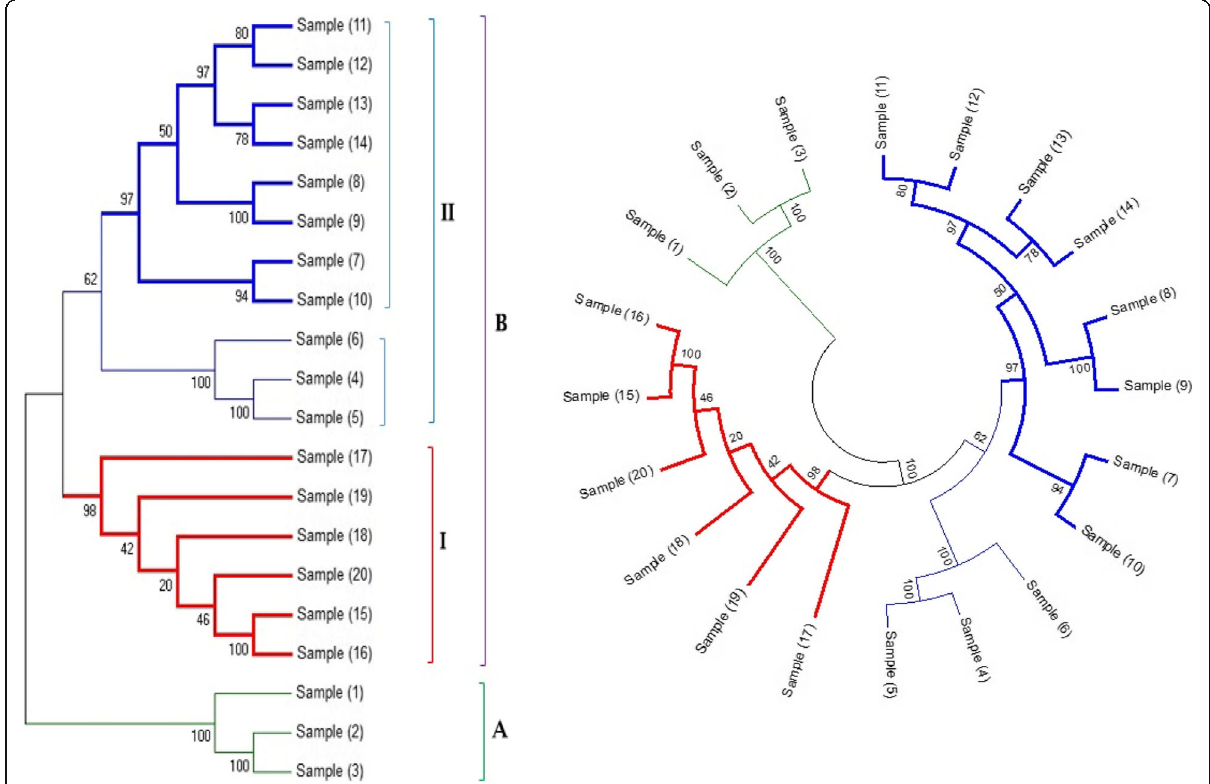
Fig. 2 Molecular phylogenetic analysis of different Triticum species by bootstrapping analysis depending on nucleotide sequence of partial matK gene. The phylogenetic analysis was performed in MEGA program version 6 by maximum likelihood method depending on the Tamura 3- parameter model. The bootstrap consensus tree deduced from 1000 replicates is obtained to determine the evolutionary history of the species analyzed. Branches corresponding to partitions reproduced in less than 50% bootstrap replicates are excluded. The percentage of replicate trees in which the associated species clustered together in the bootstrap test (1000 replicates) are shown next to the branches (Felsenstein,